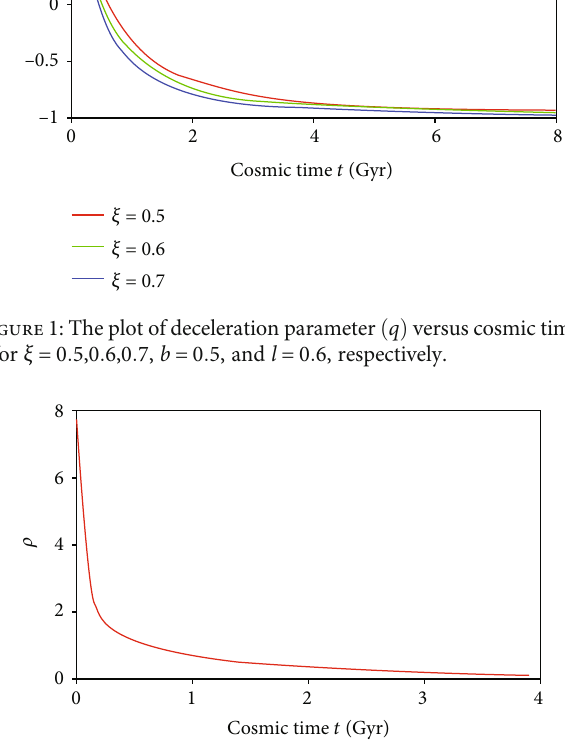
Figure 3: The plot of dark energy density ð ρ for ξ = 0 : 6 , l = 0 : 6 , ε = − 0 : 67 , b = 0 : 5 , and ρ